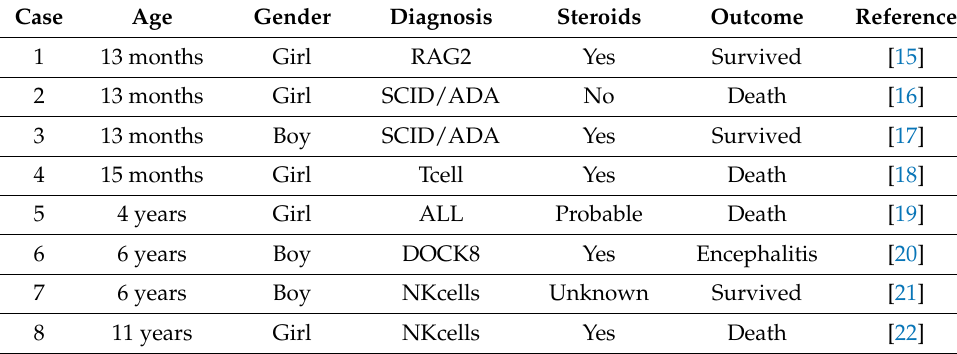
Table 1. Serious adverse events in vaccinated